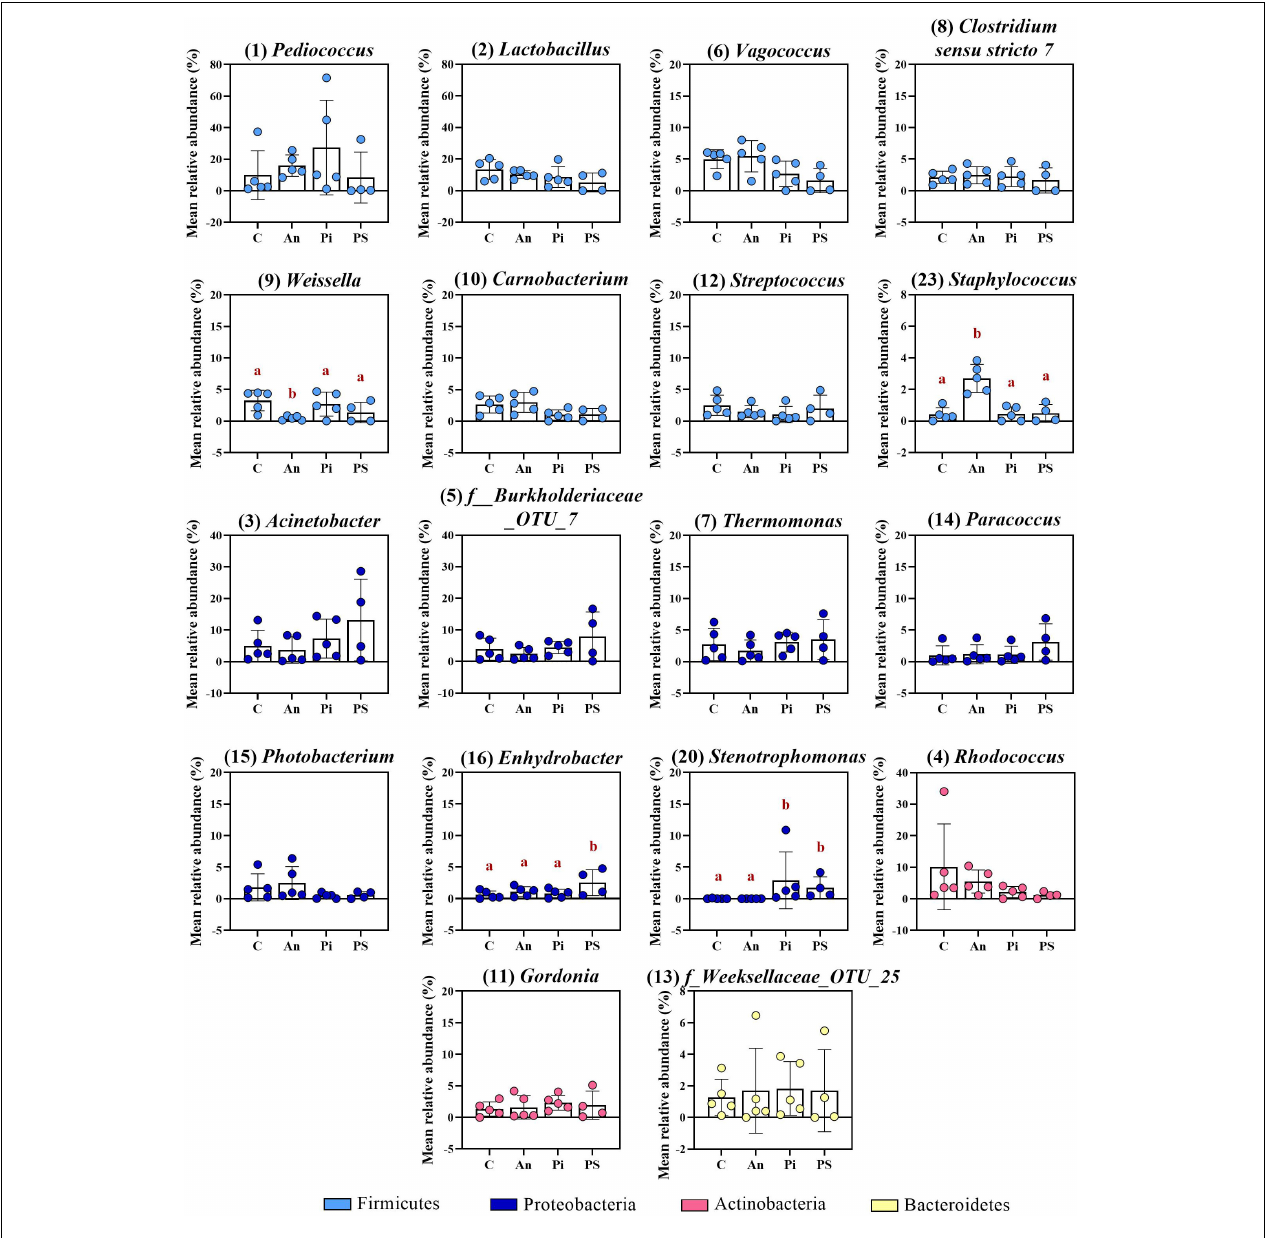
FIGURE 3 | Top-16 most abundant, plus two additional genera, selected among the top-30 (day -1). The selection of the additional genera was based on abundances presenting statistically significant differences to C (all top-30 genera were tested). The number in parenthesis states the position of the genus in the ranking. Values represent the mean and SD of five samples except for group fed with phage-sprayed feed ( n = 4). Differences are tested by ANOVA or Kruskal–Wallis ( P -values are adjusted for multiple comparison). When significant, differences are presented with different red letters. C, control feed group; An, antibiotic feed group; PI, phage-immobilized feed group; PS, phage-sprayed feed group. See Supplementary Table 4 for more information on the top-30 most abundant genera at day -1.